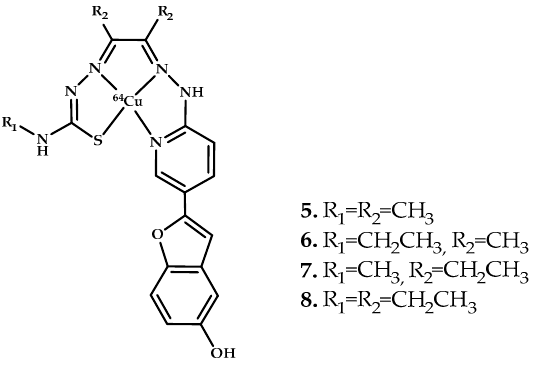
Figure 4. 64 Cu(II)–ATSM derivatives 5 – 8 conjugated with benzofuran functional group, designed for A β fibrils visualization.